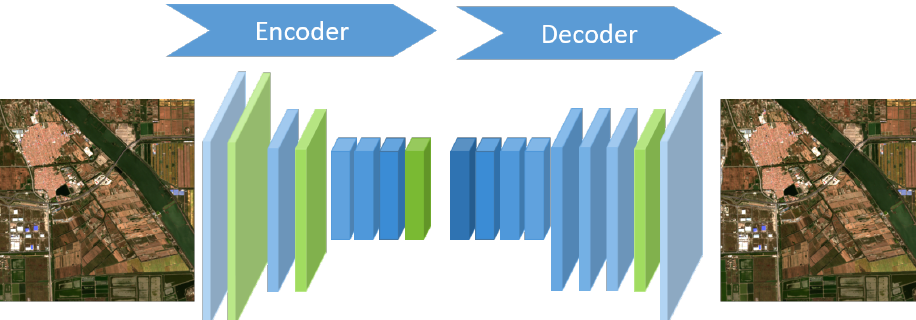
Figure 5. The architecture of our autoencoder for extracting feature maps. It consists of an encoder module and a decoder module. We mark some layers to green as the feature maps we